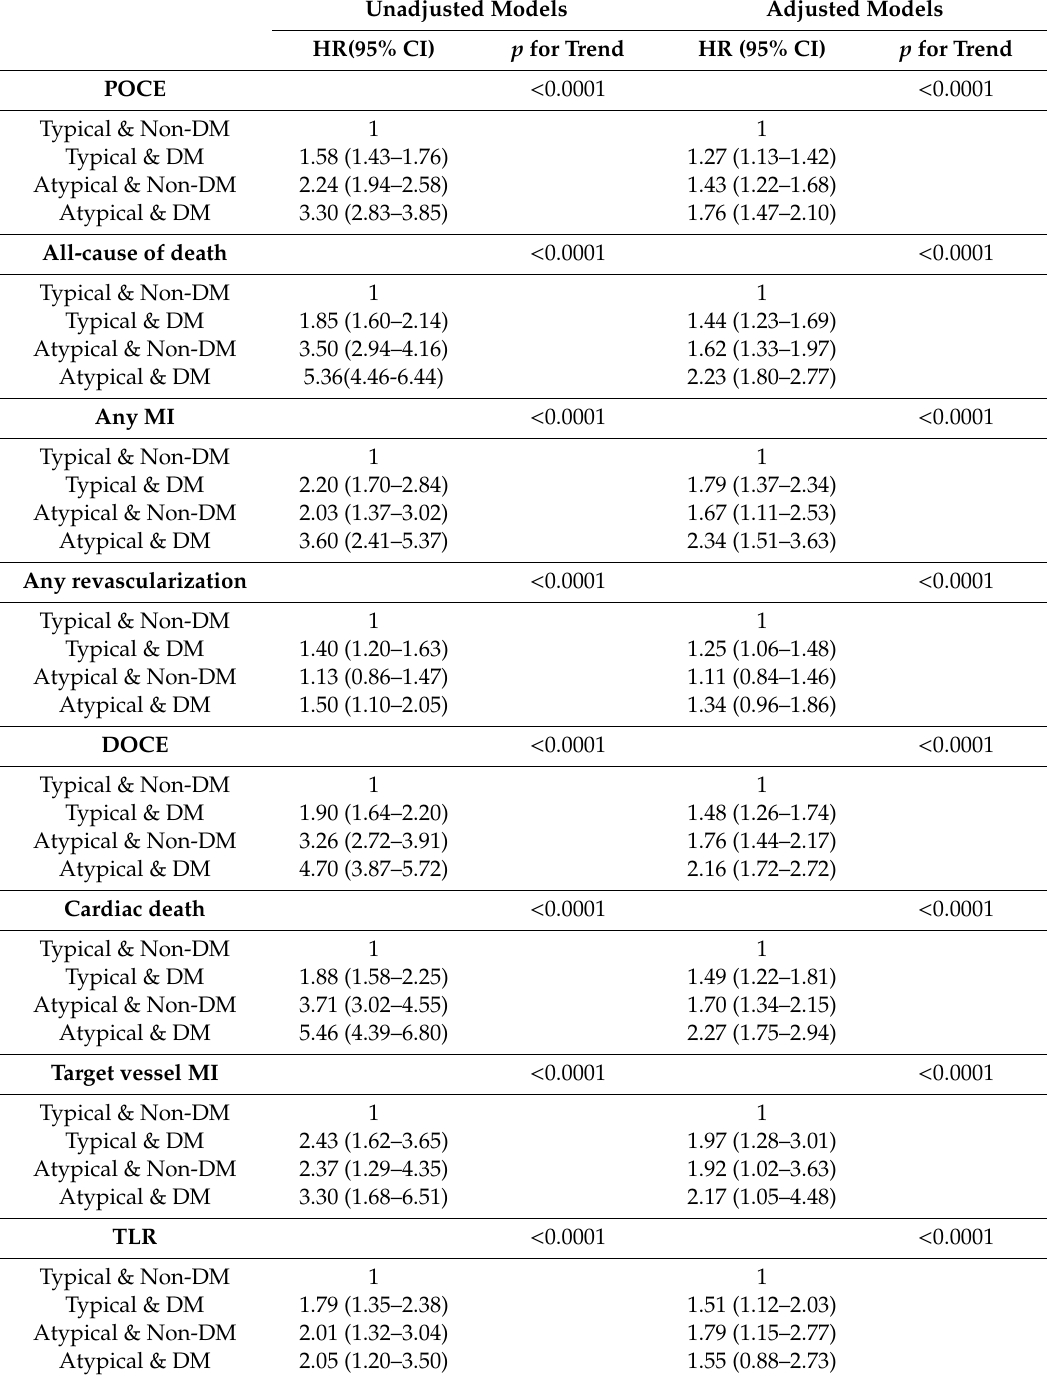
Table 4. Hazard ratio estimates from logistic regression analysis of the associations for 2-year clinical